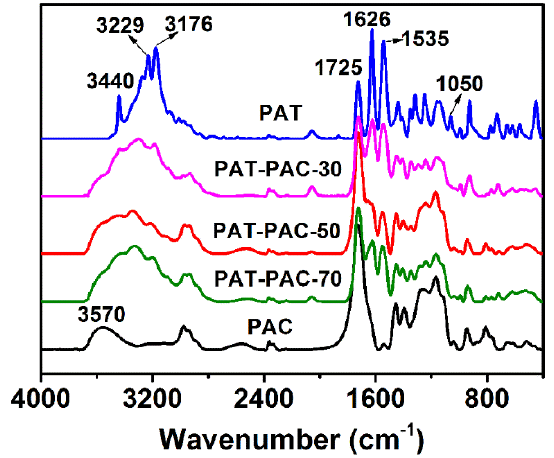
Figure 1. FTIR of dry hydrogels. PAT is poly allylthiourea, PAC is poly acrylic acid, PAT–PAC is poly (allylthiourea-co-acrylic acid).